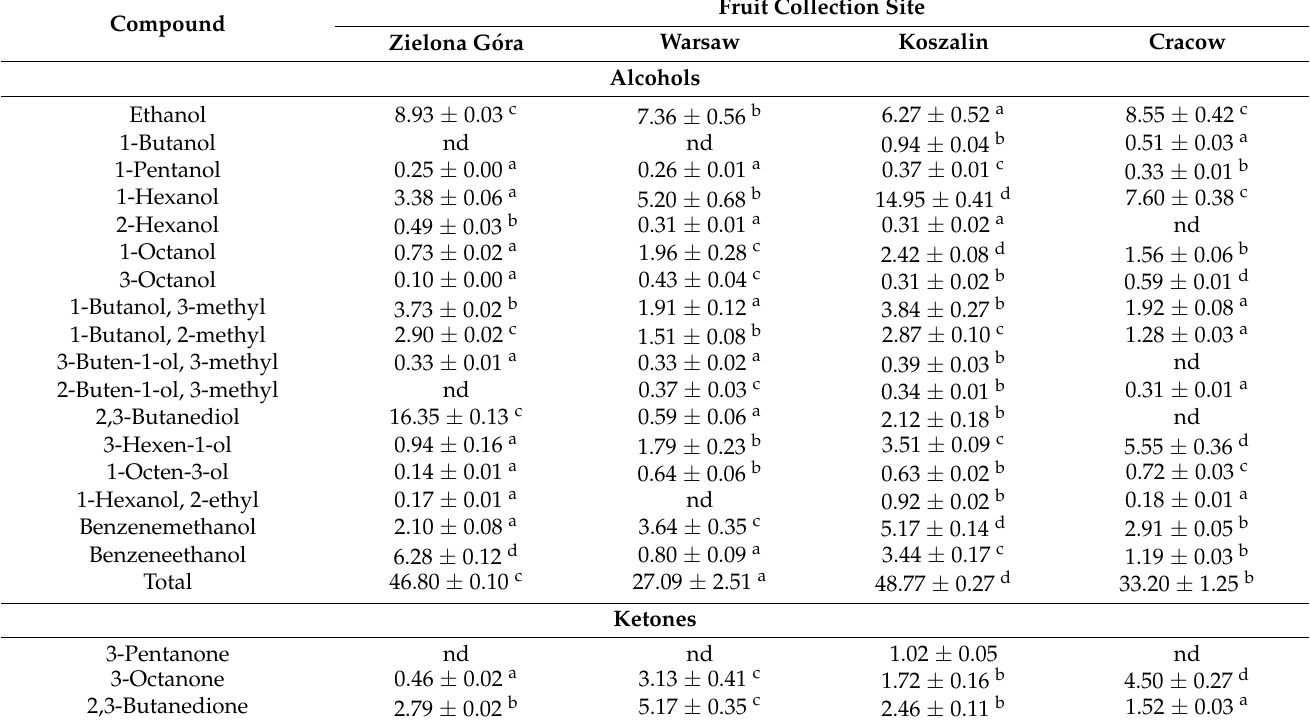
Table 3. Volatile compounds (%) of red arils (means ±